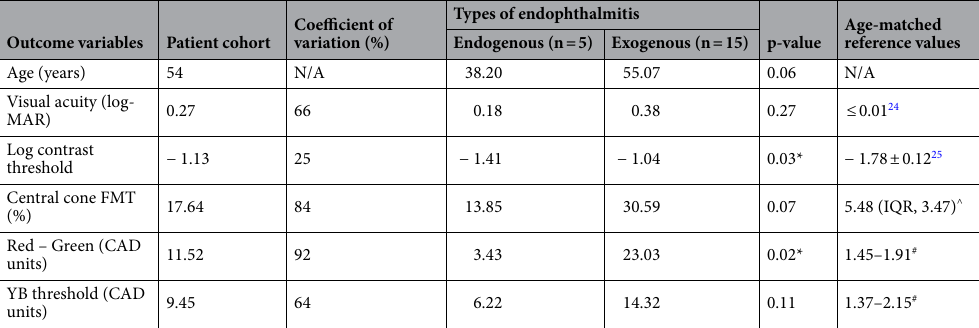
Table 2. Age profile and median of the outcome variables of the patients. ^Refers to median value obtained from 77 normal healthy adults (Age range 35–65 years) 23 . # Refers to the lower and upper limits for R-G and B-Y chromatic thresholds (Age range 35–65 years) 21 . p values obtained from comparison between exogenous and endogenous endophthalmitis using independent samples Mann–Whitney test. *Refers to the functions that are statistically significant (p < 0.05).